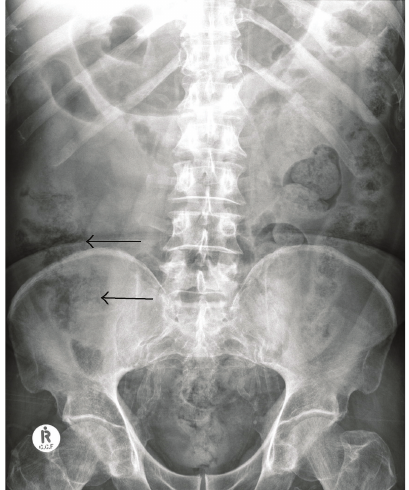
Figure 1: Supine abdomen demonstrates extensive pelvic vascular calcification. However no radio-opaque calculi are present. The bowel gas pattern was initially considered to be normal, but closer inspection demonstrates pneumatosis intestinalis within the cecal wall (arrow).